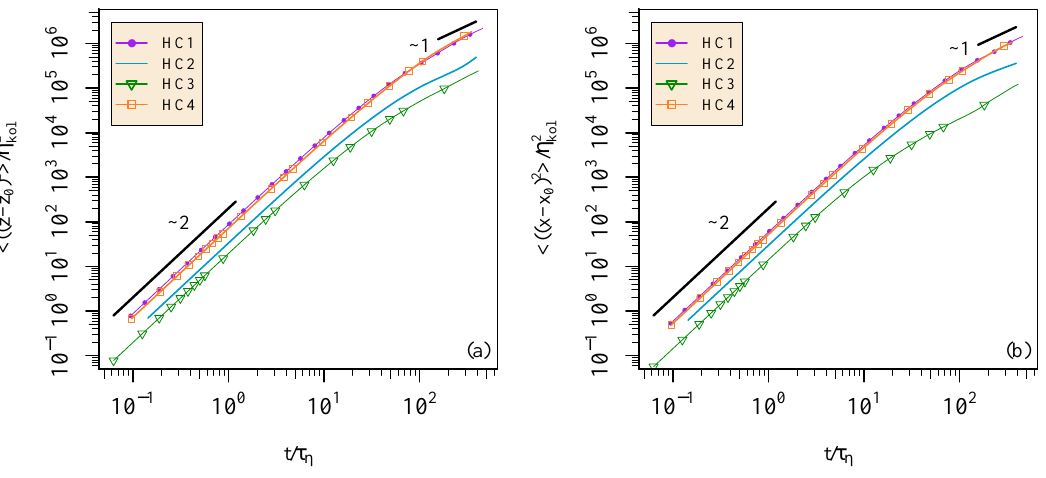
Figure 3. Lagrangian single-particle diffusion curves in the direction ( a ) parallel to gravity, and ( b ) perpendicular to gravity for simulations HC1, HC2, HC3, and HC4. Time is given in units of the Kolmogorov time-scale τ η